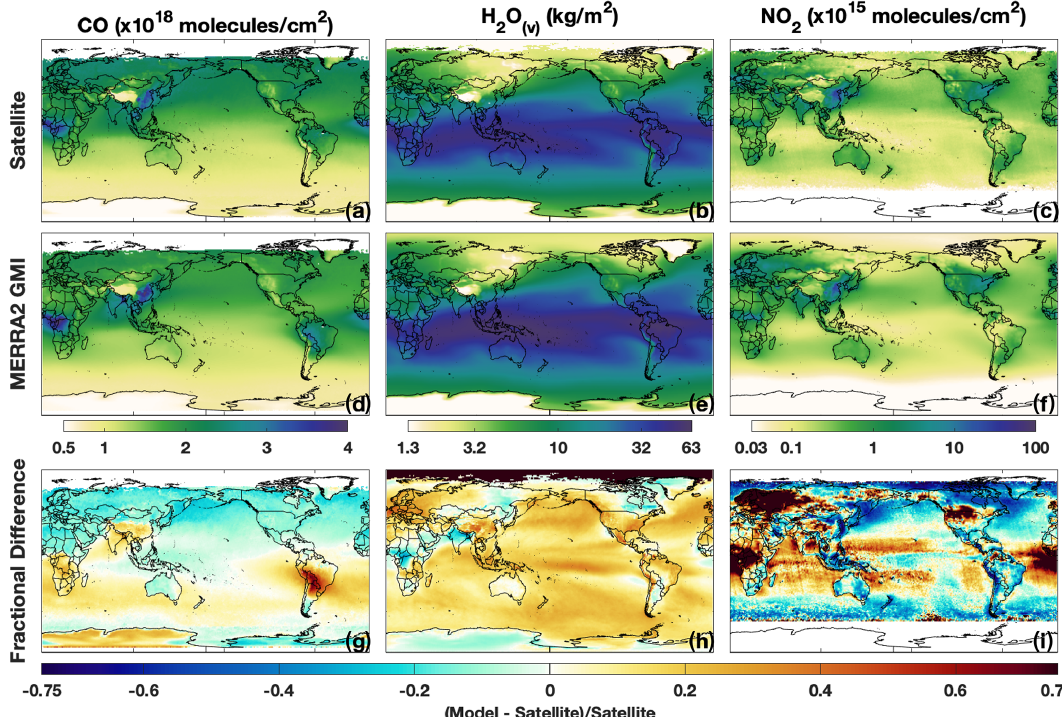
Figure 2. Tropospheric column CO (a, d, g) , H 2 O ( v ) (b, e, h) , and NO 2 (c, f, i) from MOPITT, AIRS, and OMI, respectively (a–c) , and MERRA-2 GMI (d–f) for DJF (December–February). For the satellite retrievals and model, data are averaged over the time range described in the text for each instrument. The fractional difference between MERRA-2 GMI and the satellite is shown in (g–i)